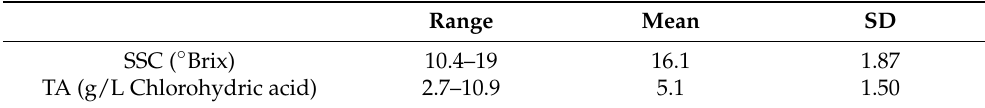
Table 1. Statistics (range, mean, and standard deviation (SD)) of the grape dataset related to SSC and